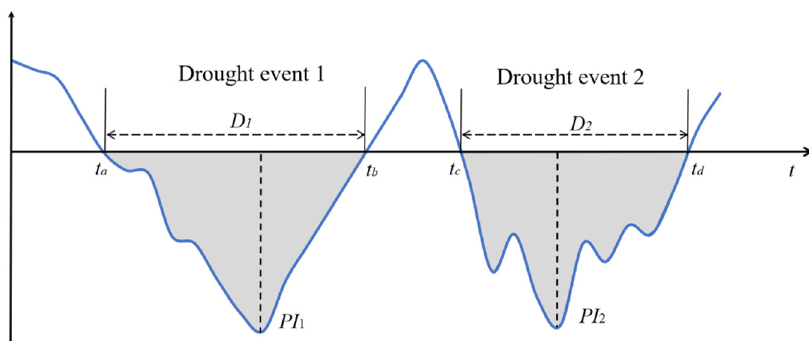
Figure 2. Schematic illustration of drought events and their characteristics ( I denotes the intensity of a drought).